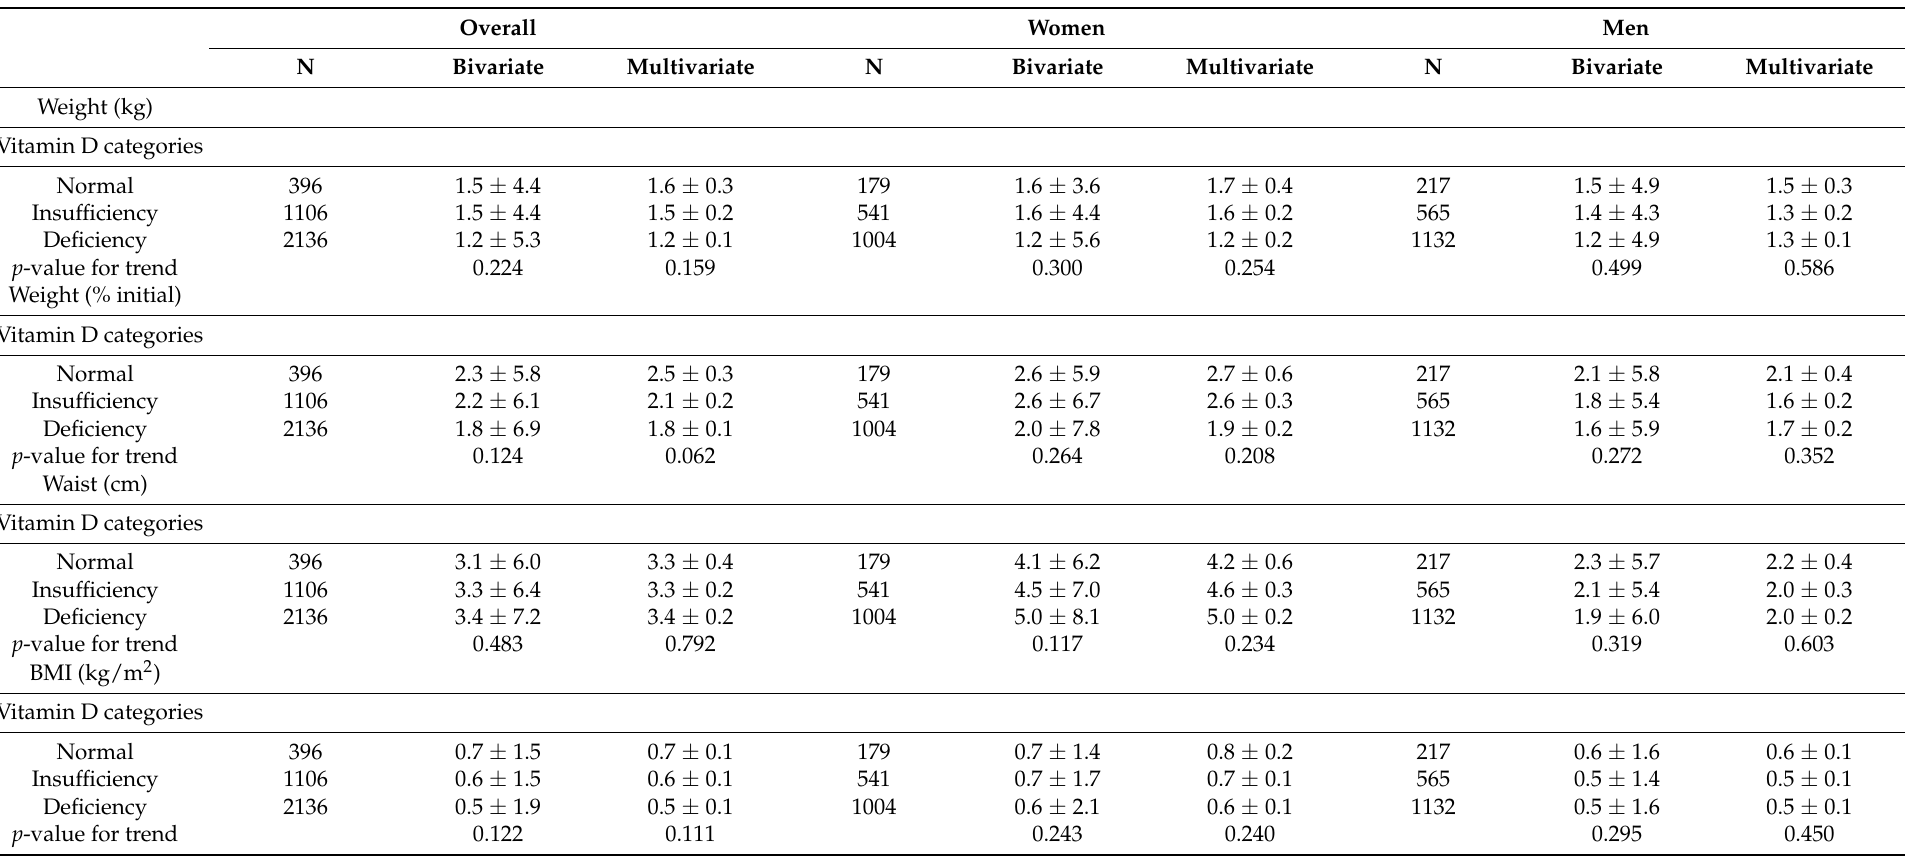
Table 1. Bivariate and multivariate comparisons of 5-year changes in weight and waist according to baseline vitamin D categories, overall and by sex, Co- Laus|PsyCoLaus study,